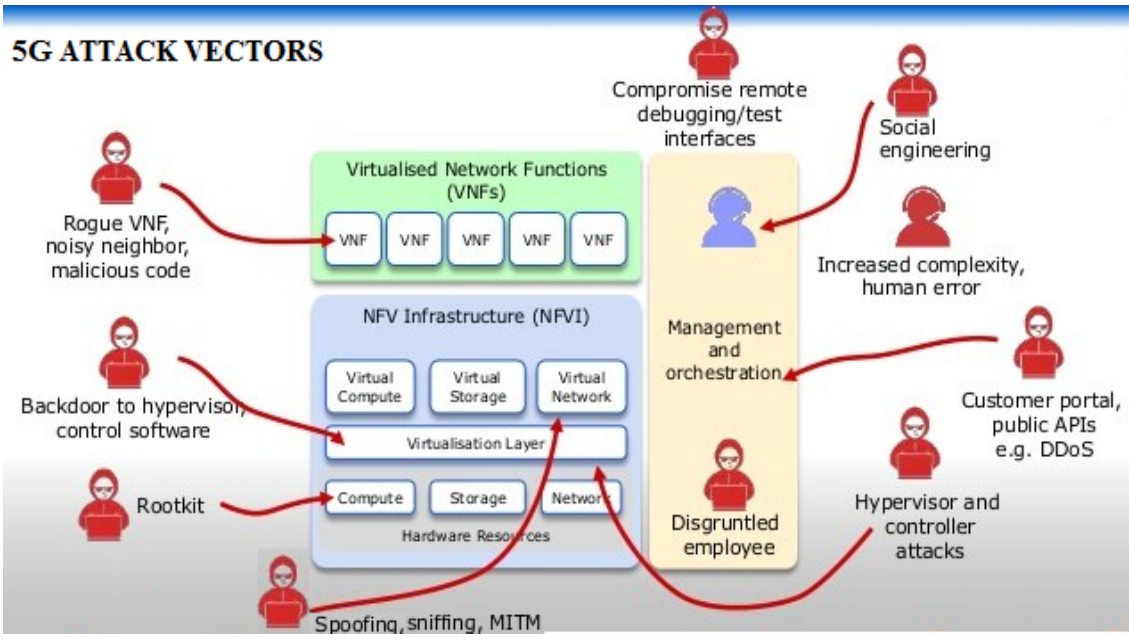
Figure 2. Attack surfaces of the 5G Network.